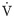
Effects of altitude and ibuprofen on the hypoxic ventilatory response (HVR = ΔV˙i / ΔSaO2).Average HVR1 (± SD), which is the initial measure of the acute HVR, is plotted for 48 hrs of treatment with placebo (Pla, gray bars) or ibuprofen (Ibu, black bars) at sea level and high altitude. There was a significant effect of altitude (p = 0.001) and altitude by drug interaction (p = 0.03). Post hoc analysis showed all of the values were significantly different from each other (p < 0.05) except the two sea level values (p = 0.22).